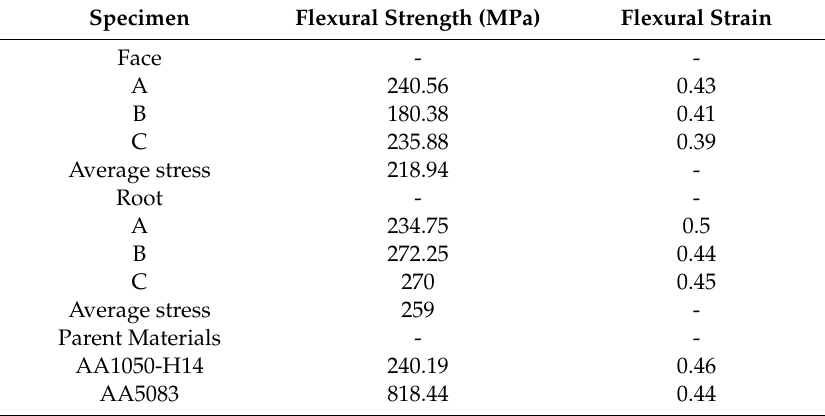
Figure 15. Bending stress—strain curves (root). Table 4. Bending test results.